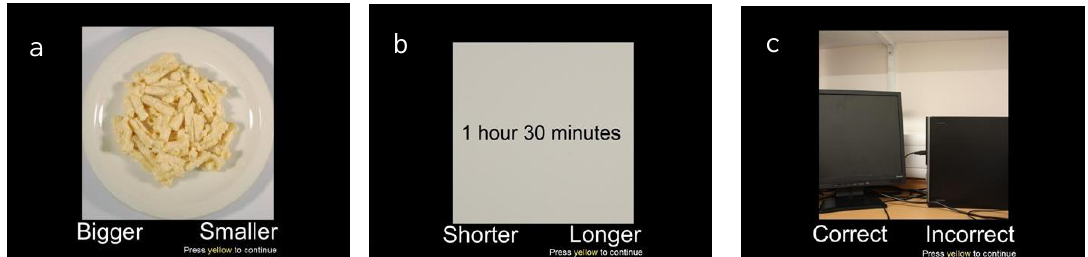
Figure 1. Example screenshots from memory for recent eating task — ( a ) portion size memory trials, in which participants indicated whether the portion on the screen was bigger or smaller than the portion they ate for the meal ( b ) interval since last ate trials, in which participants indicated whether the time on the screen was a shorter or longer time period than when they finished eating ( c ) spatial memory trials, in which participants indicated whether the image on the screen was in the correct or incorrect (mirror image) spatial layout of the environment in which the meal was consumed.